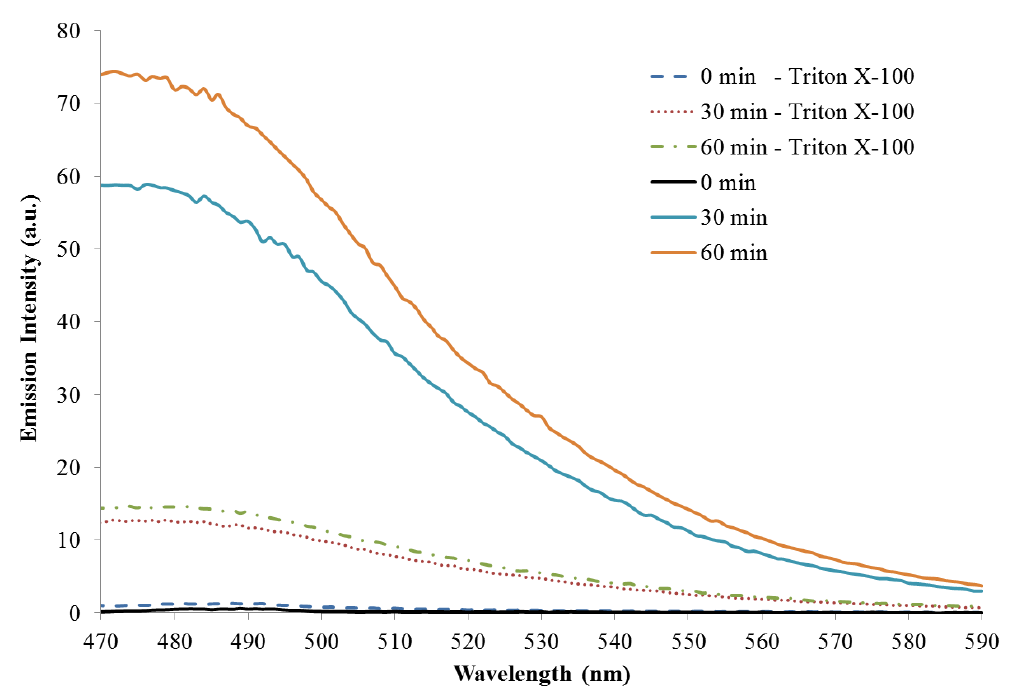
Figure A6. Fluorescence emission (λ ex = 420 nm) as a function of reaction time with and without Triton